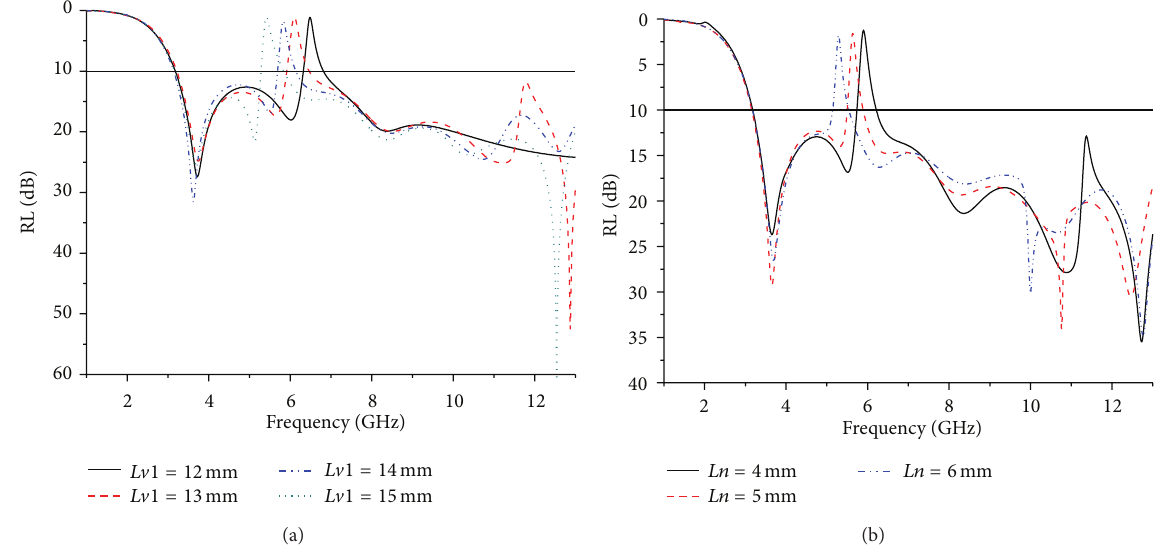
Figure 7: Band notch versus frequency (a) for different values of the parameter Lv1 (other parameters: Lv2 = 0mm, Ln = 4mm, S = 0.2 mm, and Ws = 1mm) and (b) for different values of the parameter Ln (other parameters: Lv2 = 0 mm, Lv1 = 13.5 mm, S = 0.2 mm, and Ws =